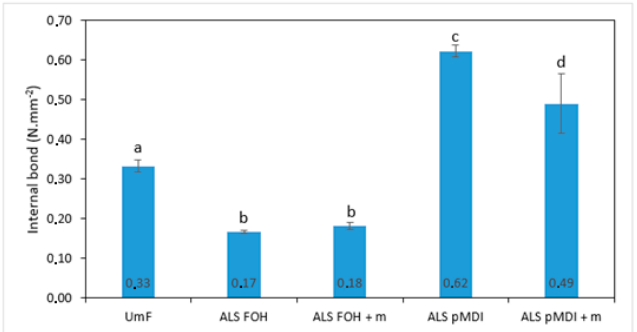
Figure 6. Internal bond strength of particleboard panels produced with urea-melamine-formaldehyde (UmF), ammonium lignosulfonate (ALS) crosslinked with furfuryl alcohol (ALS FOH), ALS FOH with mimosa tannin (ALS FOH + m), ALS crosslinked with pMDI (ALS pMDI) and ALS pMDI with mimosa tannin (ALS pMDI + m), and with or without mimosa tannin (m). Error bars represent standard deviations. Values labeled with di ff erent letters (a, b, c and d) are statistically di ff erent at an error probability of α = 0.05 (Tukey’s HSD test).